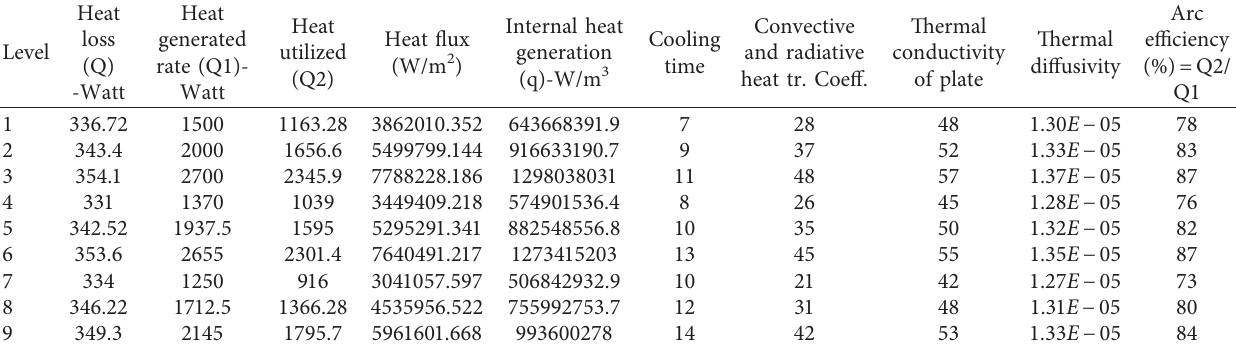
Table 4: Thermal results of single V 45 ° .